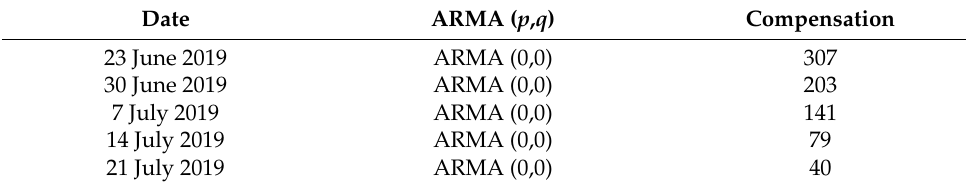
Figure 7. Schematic representation of rolling error compensation.